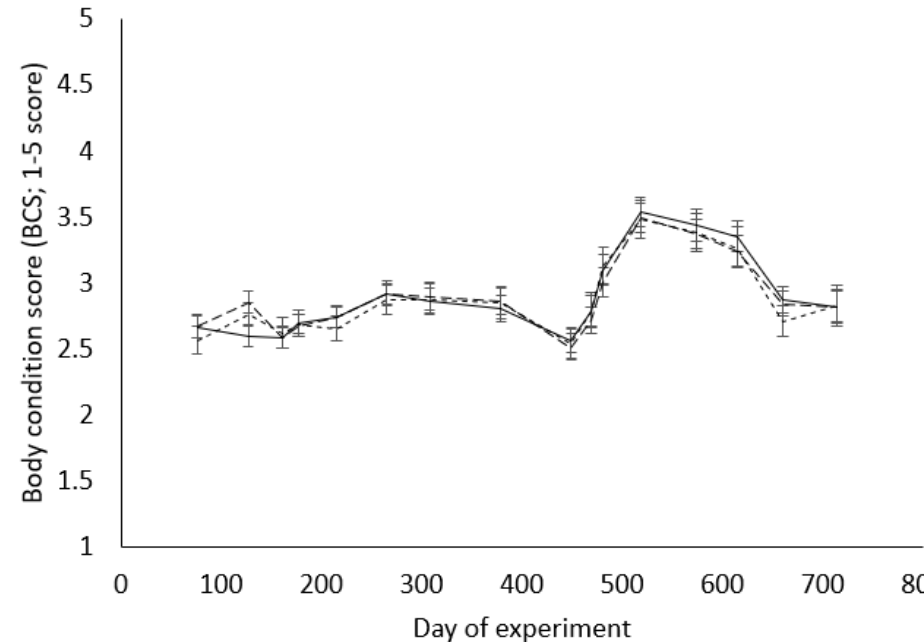
Figure 2. Body condition scores (BCSs; 1–5 score) of ewes born to mature ewes as twins (M2; —), or born to ewe lambs as singletons (L1; – –) or as twins (L2; ---), from D76 after their weaning (D0) to the weaning of their second lambs (D714). Values are back-transformed LS means and error bars indicate 95% confidence intervals.